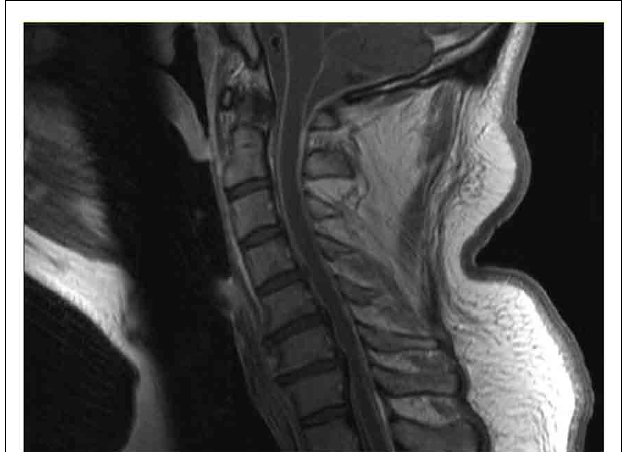
FIGURE 3 | SagittalT1 post-contrast MRI of the cervical spine shows diffuse leptomeningeal enhancement in the posterior fossa and cervical spine.